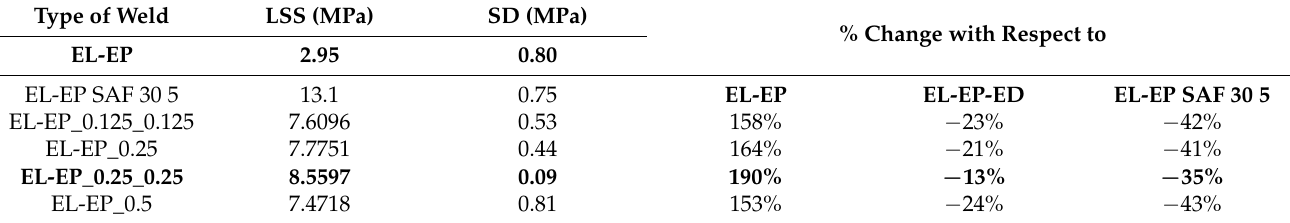
Table 3. Maximum LSS of different weld configurations.